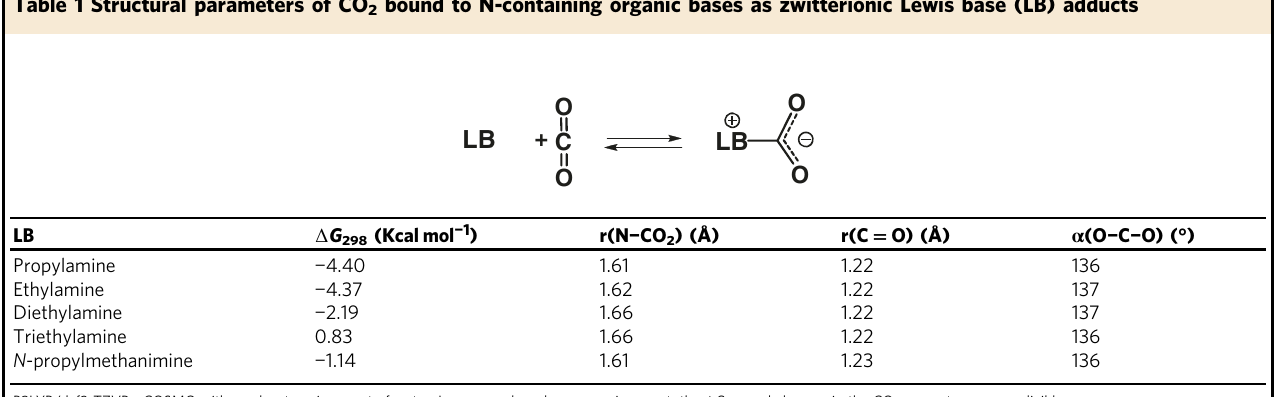
Table 1 Structural parameters of CO 2 bound to N-containing organic bases as zwitterionic Lewis base (LB)